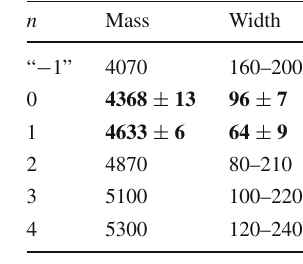
Table 2 Orbital trajectories of the (cid:3)( 4360 ) and (cid:3)( 4660 ) . Here we use = 0 . 88 GeV − 2 to predict orbitally excited partners of the slope of α (cid:2) J the two states. If the states are tetraquarks there may be a lower state with J PC = 0 ++ as the ground state (which would not be the case